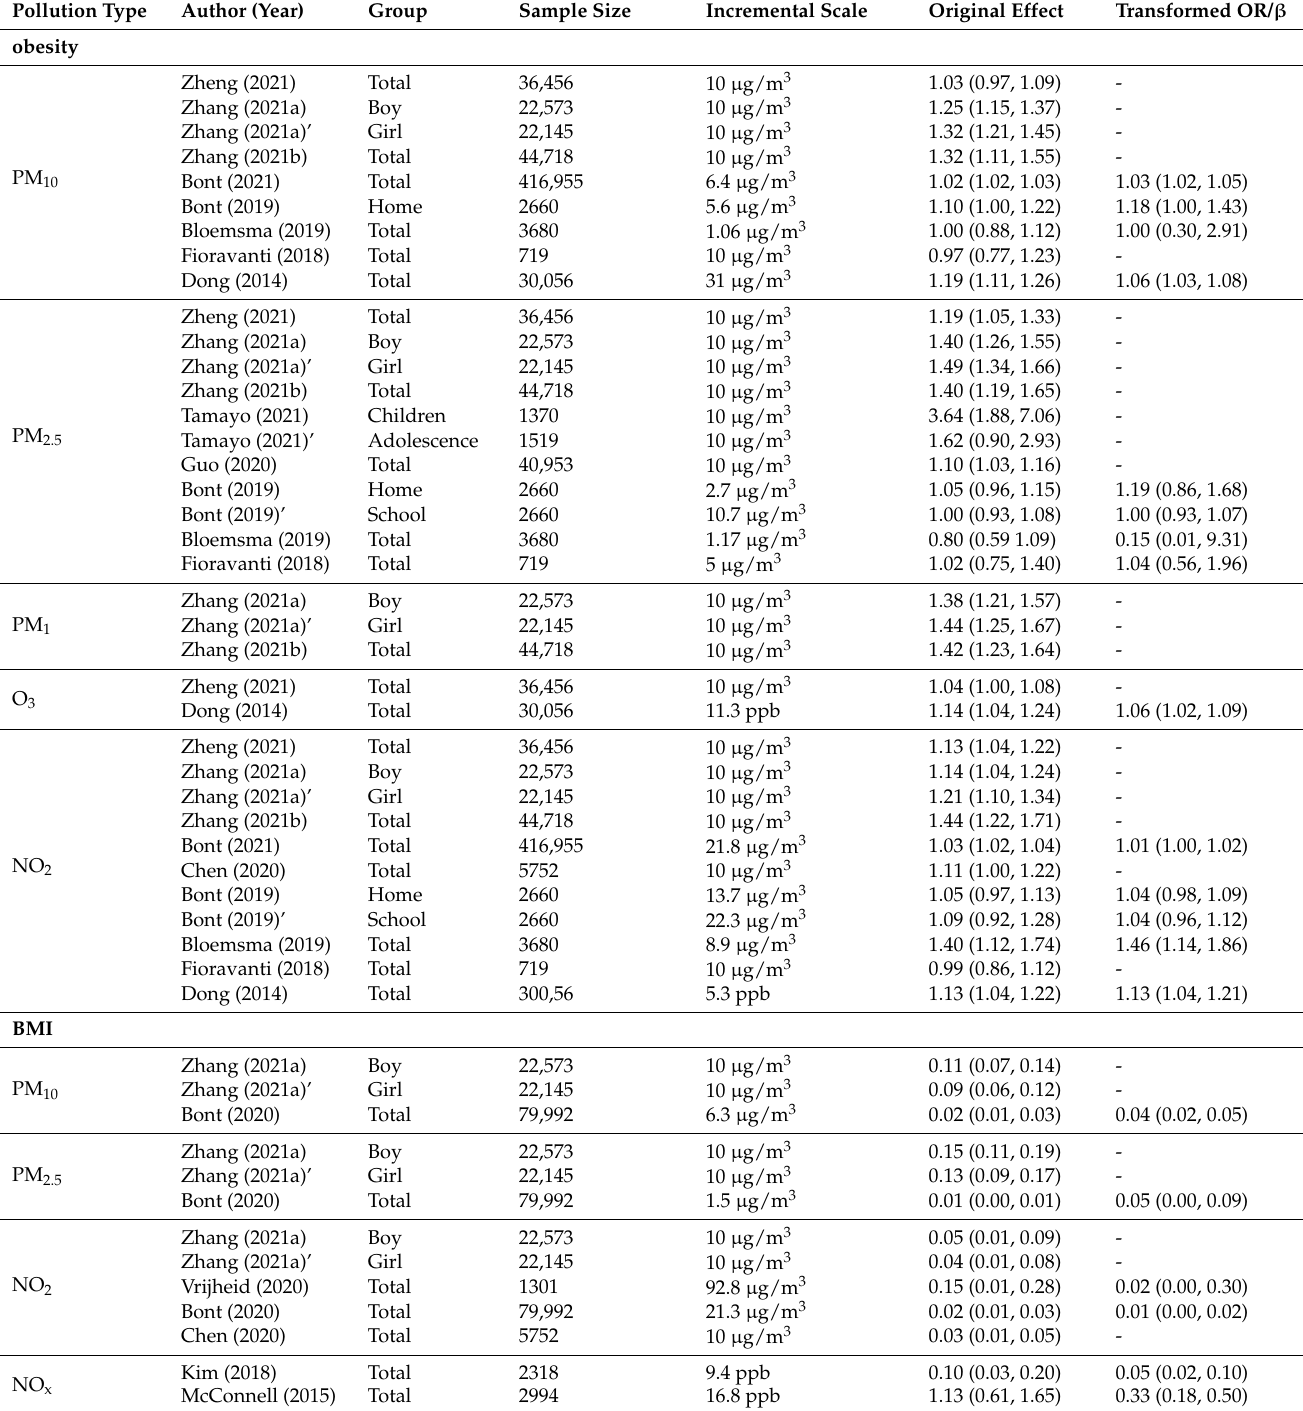
Table 3. Summary effects and 95% confidence intervals of each pollutant on obesity and BMI in children and